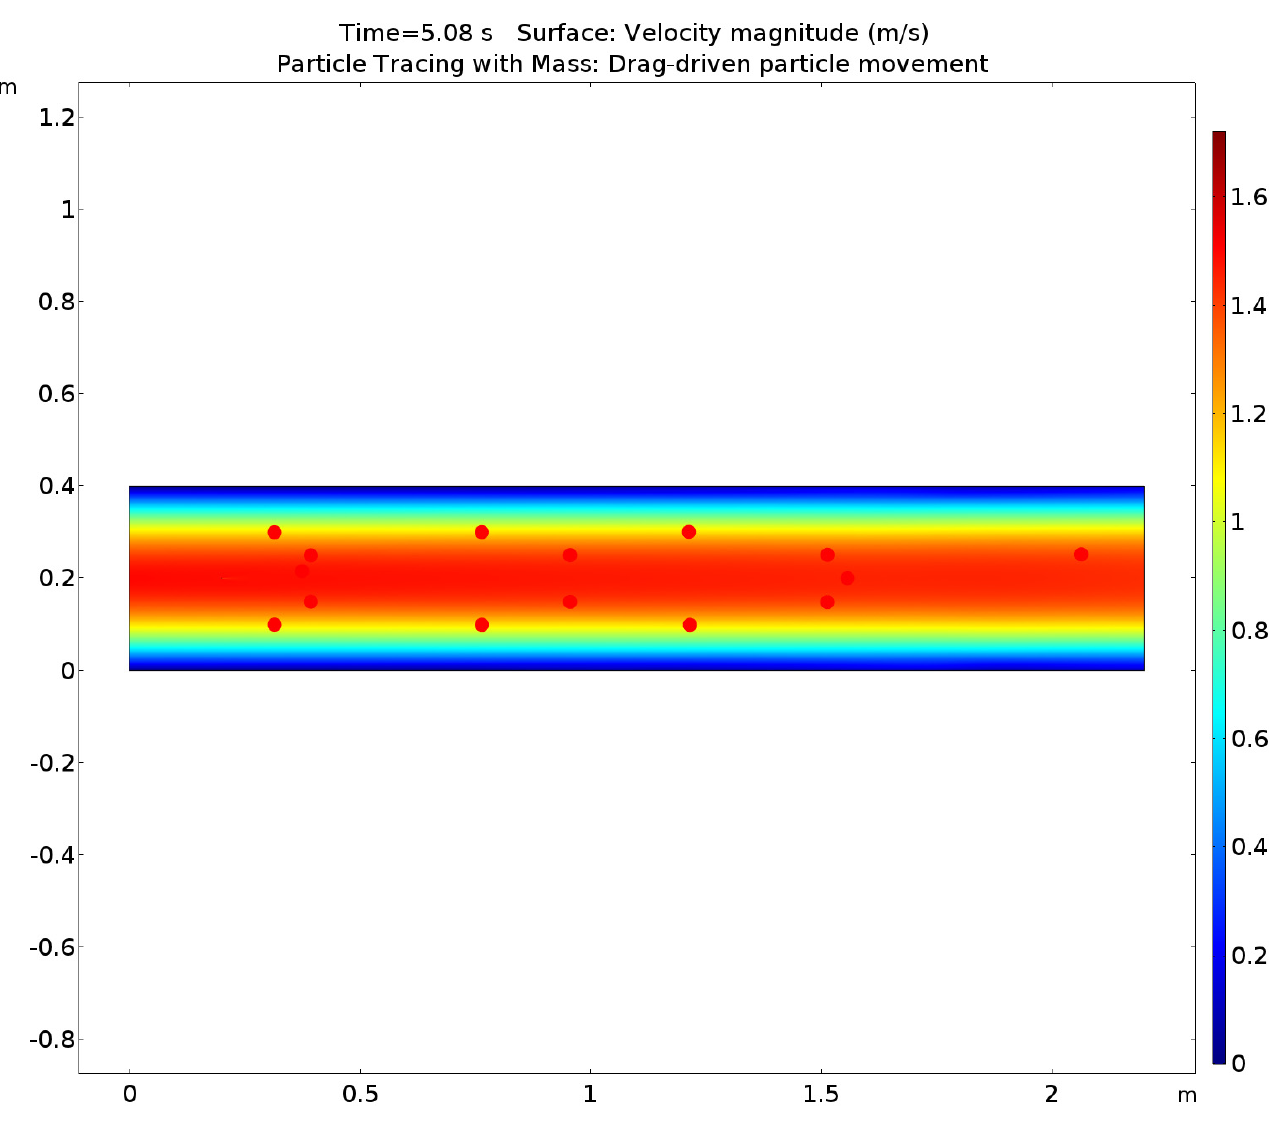
Figure 10. Non-isotropic ( Top ) and isotropic ( Down ) filler distribution in polymer composite.